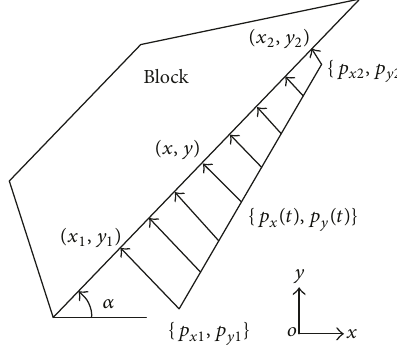
Figure 1: Water pressure on the